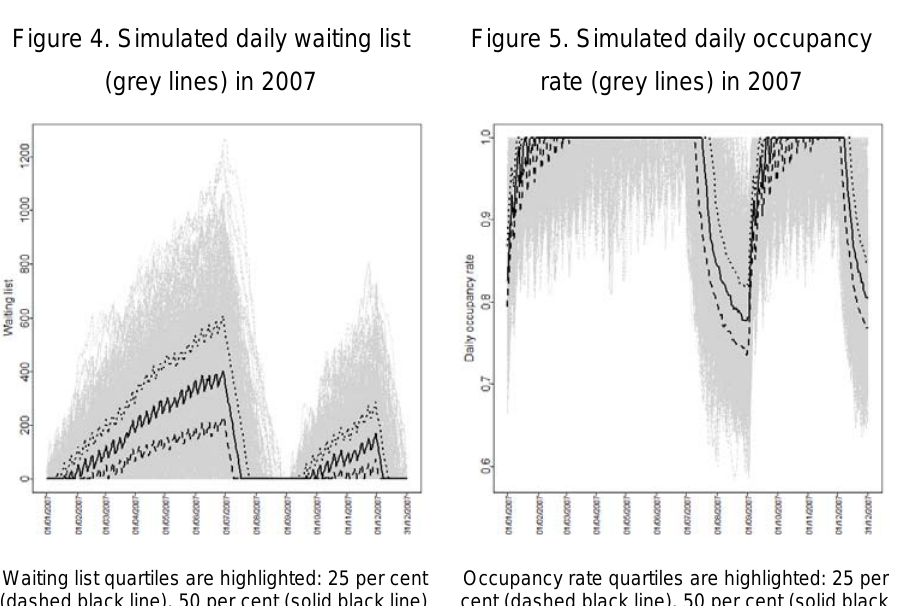
Waiting list quartiles are highlighted: 25 per cent (dashed black line), 50 per cent (solid black line)